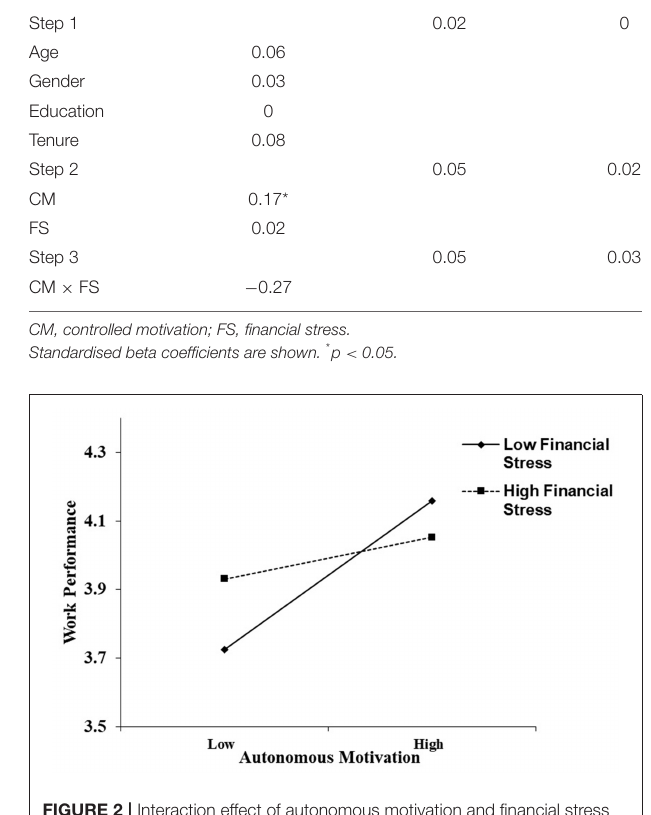
FIGURE 2 | Interaction effect of autonomous motivation and financial stress on work performance. Conditional regressions of work performance on autonomous motivation were conducted when financial stress was high ( M + 1 SD ) and low ( M − 1 SD ). Endpoints of the lines represented the scores of work performance when autonomous motivation was low or high.